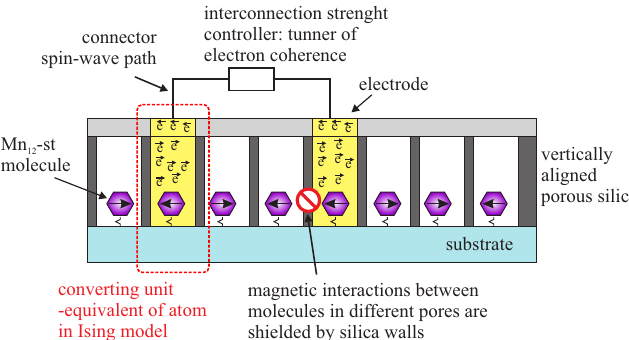
Figure 13. A schematic illustration of the molecular neural network with two interacting molecular neurons (processing units).